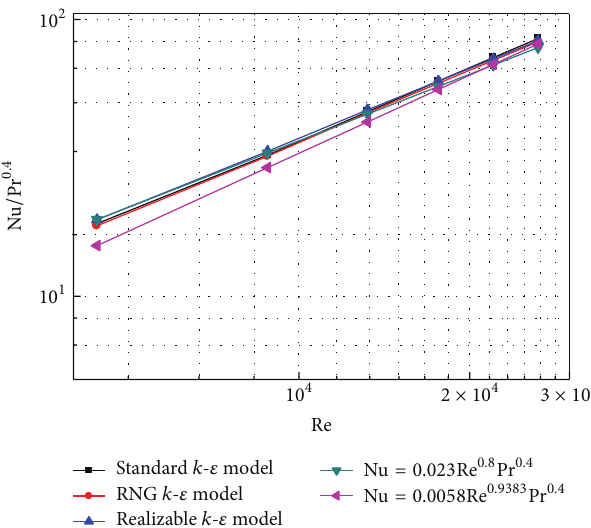
Figure 8: Comparison of different 𝑘 - 𝜀 models and empirical